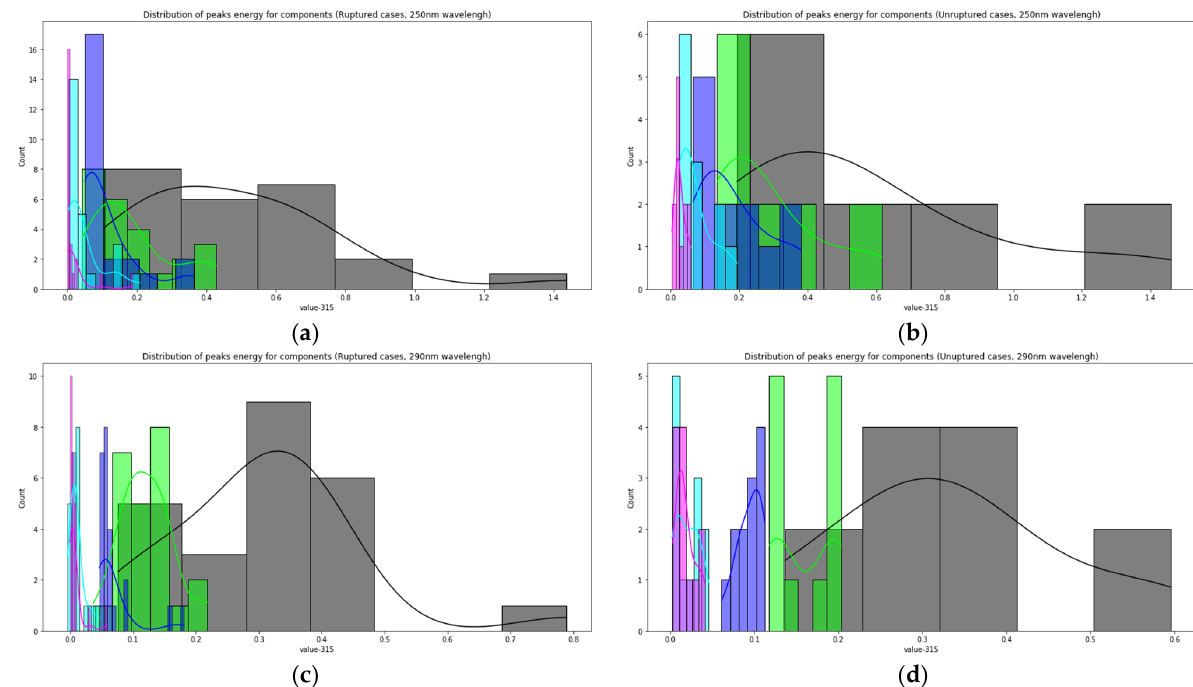
Figure 7. The relationship between the magnitude of the peaks of the LIF components and the status of aneurysms: distribution of peaks energy for components (Ruptured cases, 250 nm wavelength) ( a ); distribution of peaks energy for components (unruptured cases, 250 nm wavelength) ( b ); distribution of peaks energy for components (ruptured cases, 290 nm wavelength) ( c ); distribution of peaks energy for components (unruptured cases, 290 nm wavelength) ( d ). Table 1. The magnitude of the error of the second kind ( p -value) for the Mann–Whitney U test for Table 2. The magnitude of the error of the second kind ( p -value) for the Mann–Whitney U test for